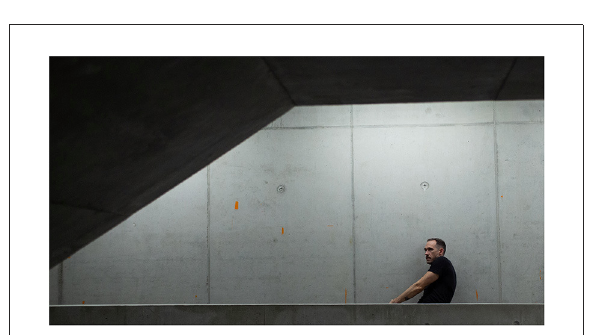
FIGURE8 Michael O’Connor tracing lines in architecture as a dance practice. Photo: Niels